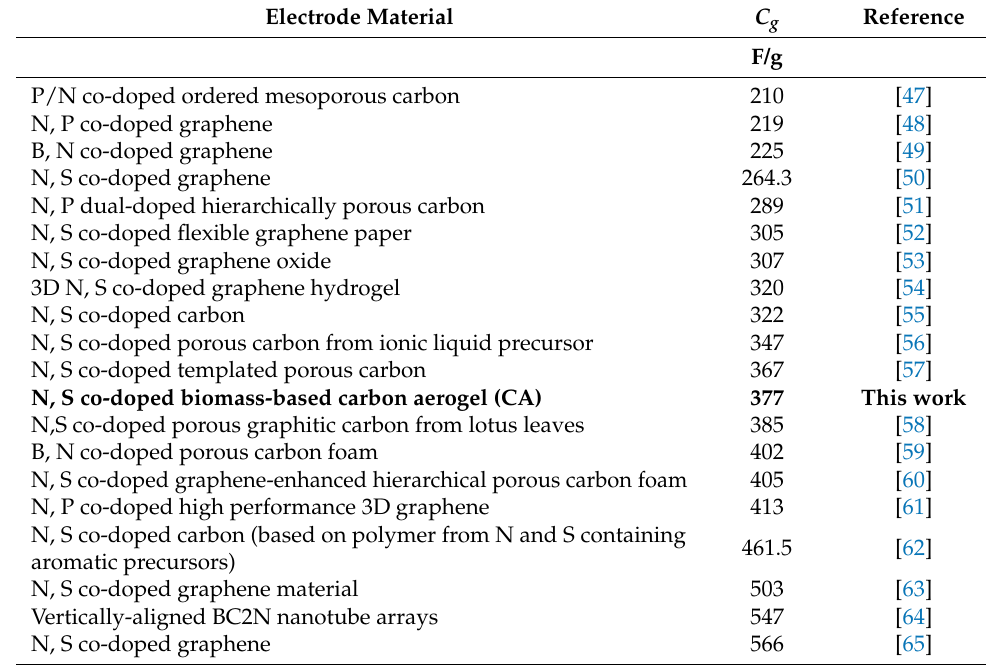
Table 4. Gravimetric capacitance of dual doped metal free carbon materials in KOH electrolyte.